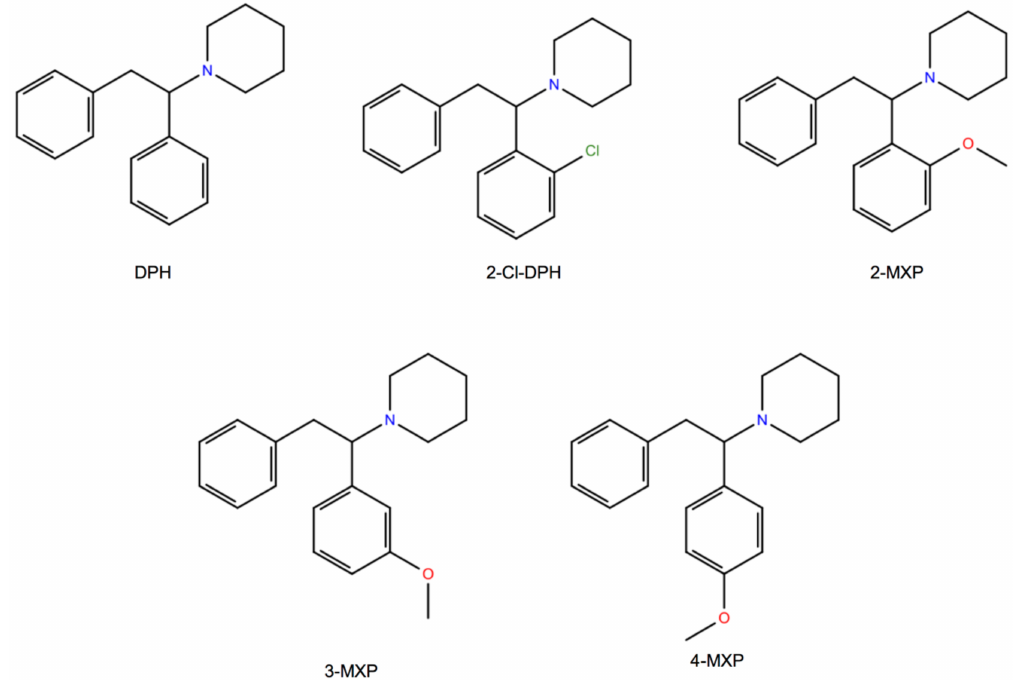
Figure 1. Molecular structures of diphenidine (DPH) and other aryl-substituted 1,2-diarylethylamines including 2-MeO-diphenidine (2-MXP), 3-MXP, 4-MXP and